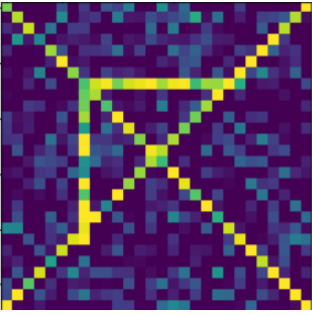
Figure 23. Object with diagonals added, with level 2 noise.